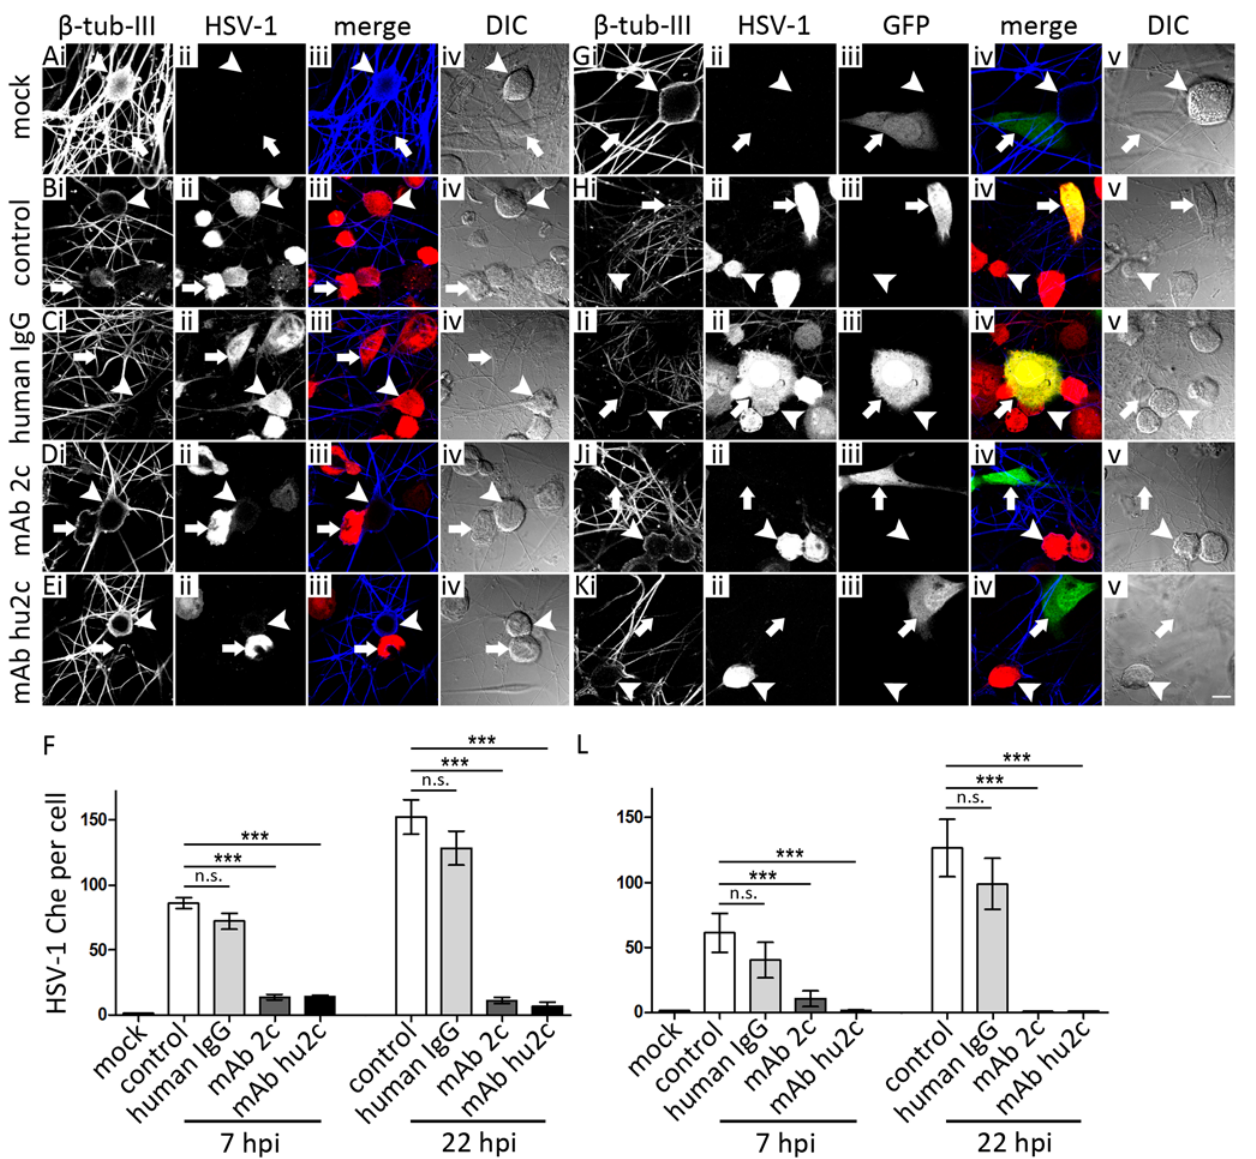
Figure 2. MAbs 2c and hu2c restrict cell-to-neuron (A-F) and neuron-to-cell spread of HSV-1 (G-L) . For the investigation of cell-to-neuron spread, epithelial C127I cells (arrows) were infected with the reporter virus HSV-1(17 + )Lox-Che. At 14 hpi cells were detached, treated with the indicated antibodies and co-cultured with uninfected DRG sensory neurons (arrowheads) (A-E) . For the investigation of neuron-to-cell transmission, DRG neurons were infected with HSV-1(17 + )Lox-Che. At 24 hpi, GFP-transfected, uninfected C127I were detached, treated with the indicated antibodies and co-cultured with the infected neurons (G-K) . For both settings, cells were fixed as indicated at 7, 22 and 30 hpi with PHEMO and labeled with anti- β -tubulin-III. Images were acquired with a confocal microscope. For the quantification of the cell-to-neuron (F) or neuron-to-cell transmission (L) , the values of mCherry-fluorescence were determined in a defined area within neurons (F) or GFP-positive C127I cells (G). (A-E and G-K) Scale bar is 10 µ m. (F and L) . Error bars show standard error of the mean (SEM) of one representative experiment. Differences between the groups were statistically significant by a nonparametric ANOVA one way test ( *** P <